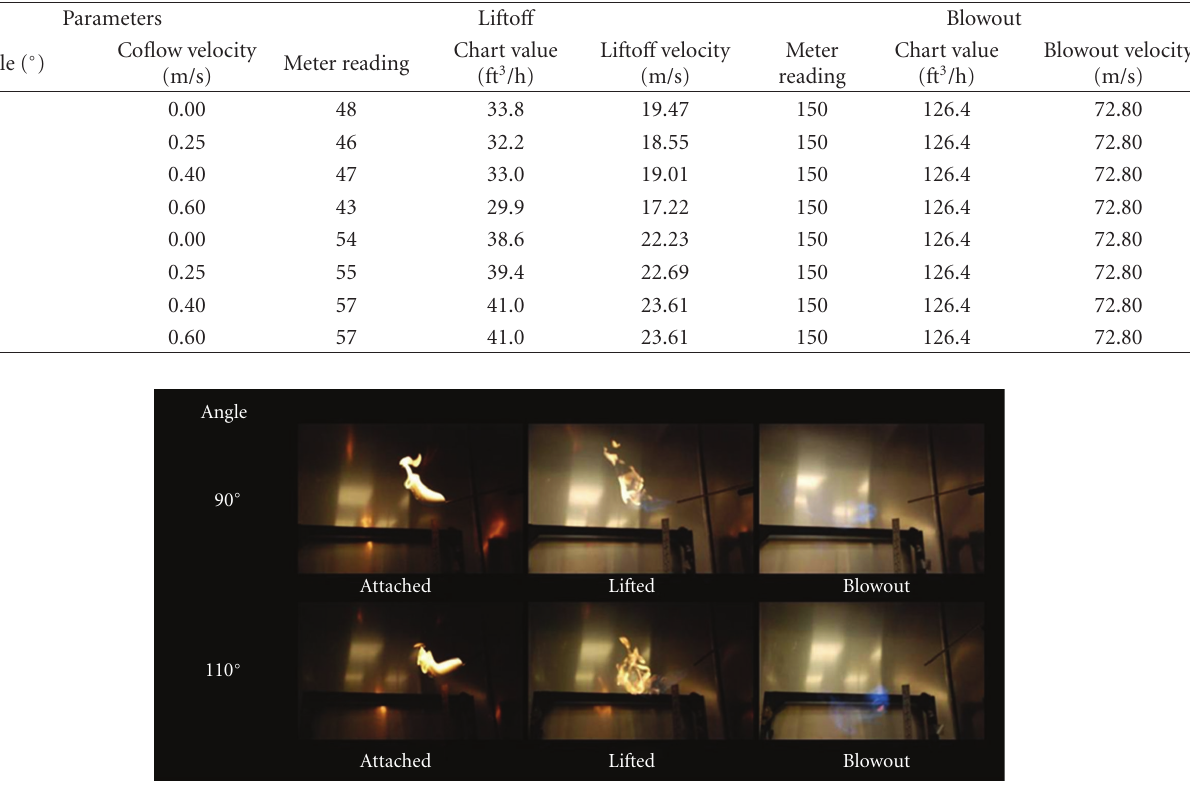
Figure 8: Flame states at high oblique angles.